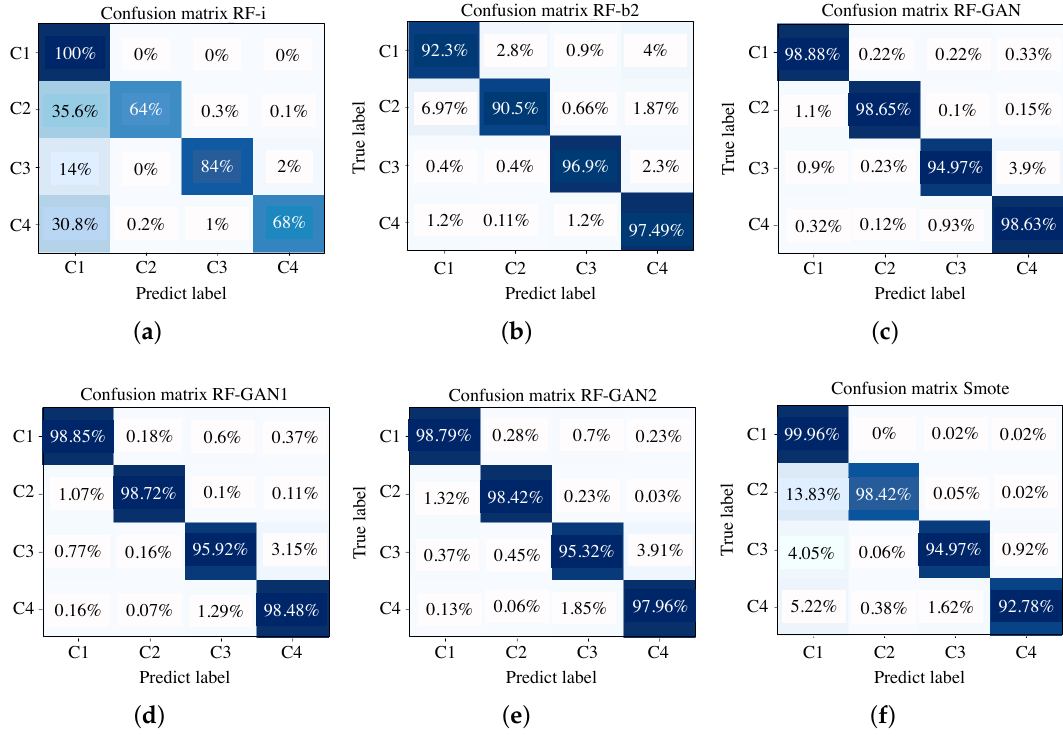
Figure 13. The confusion matrix for: scenario: ( a ) RF-i; and ( b ) RF-b2; ( c ) RF-GAN; ( d ) RF-GAN1; ( e ) RF-GAN2; and ( f )